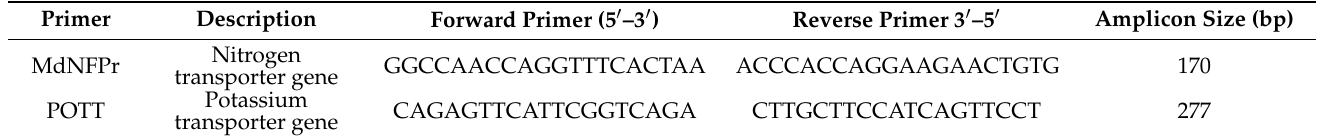
Table 4. Primer sequences for amplification of nutrient transporter genes in apple with expected amplicons lengths. Primer